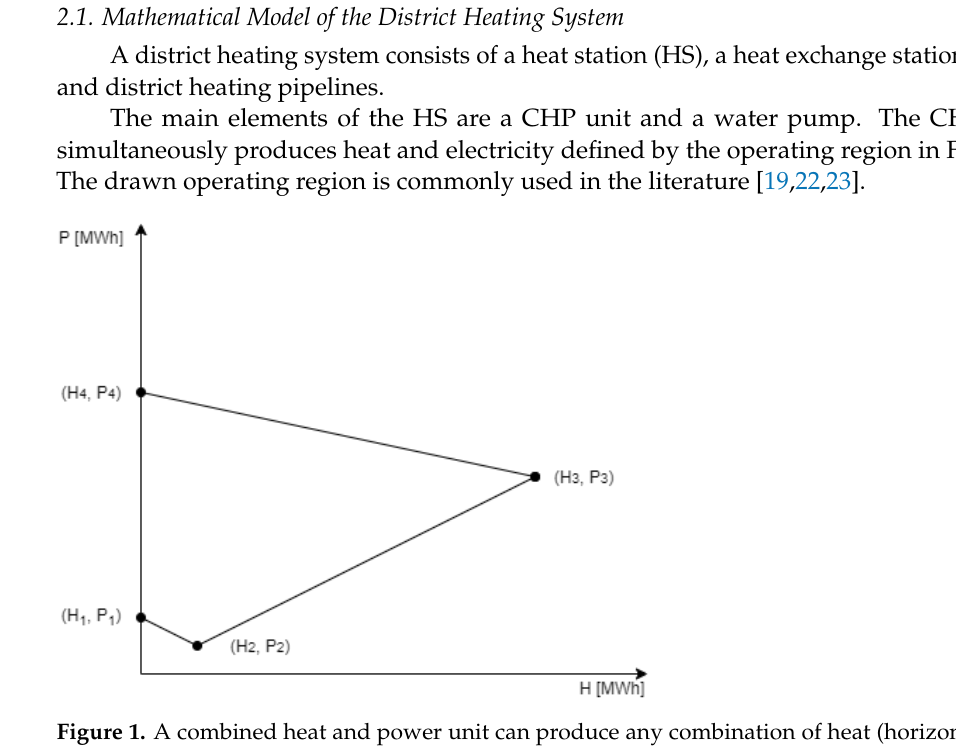
Figure 1. A combined heat and power unit can produce any combination of heat (horizontal axis) and power (vertical axis) within the region spanned by the four corner